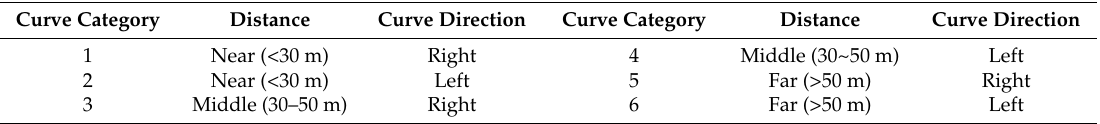
Table 1. Categories of Tested Curves.